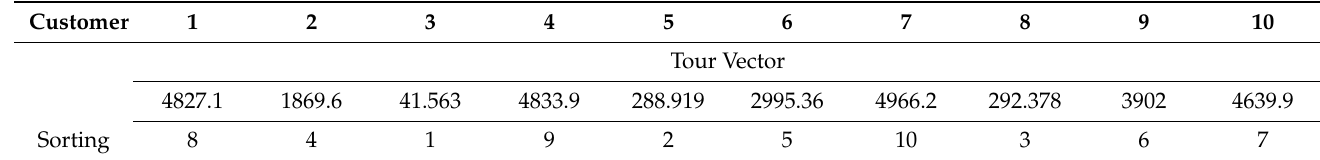
Table 3. Representation of a tour vector to a valid routing.